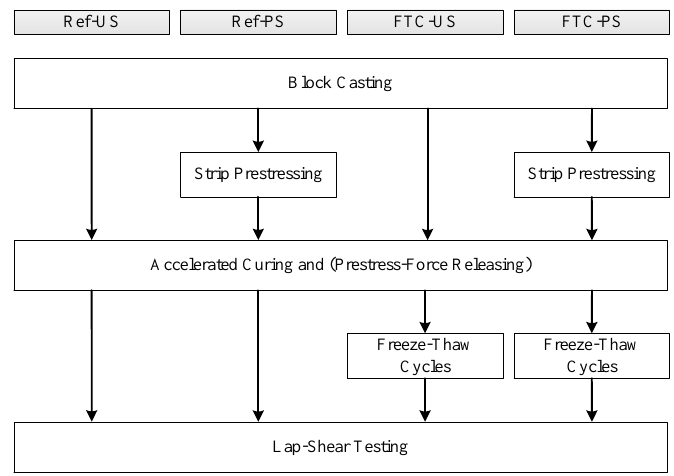
Figure 2. Chart summarizing key steps for each testing scenario of the experimental